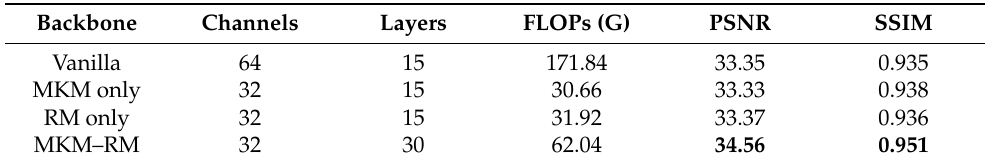
Table 2. Denoising effects of different feature extraction networks. The best quantitative results are marked in boldface.